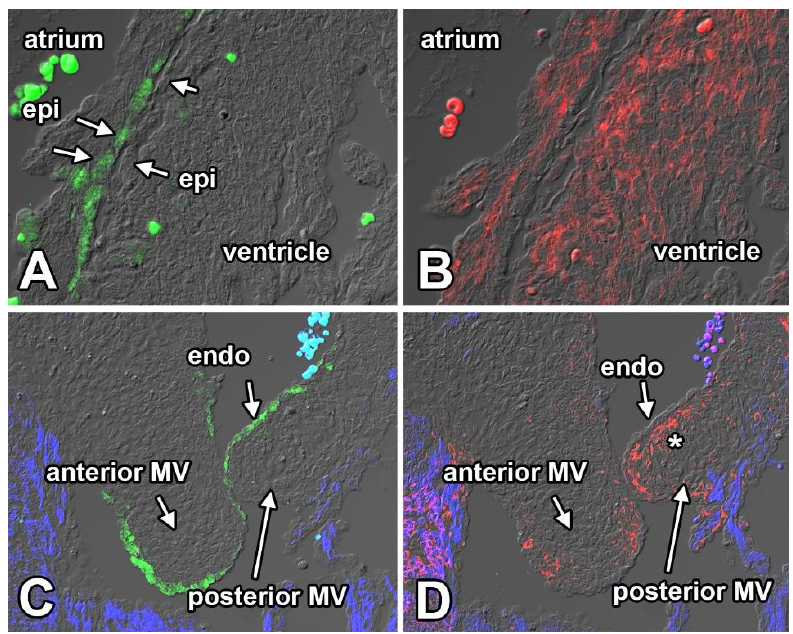
Figure 7. α4 Integrin and VCAM-1 expression. Immunostained sections of a 13.5 ED heart labeled for α4 Integrin (green in A , C ) and VCAM-1 (red in B , D ) and myosin heavy chain (blue in C , D ). The figure shows expression of α4 Integrin in the atrial epicardium ( A ) and valve endocardium ( C ) and expression of VCAM-1 in atrial and ventricular myocardium ( B ) and valve mesenchyme (asterisk in D ). endo, endocardium; epi, epicardium.